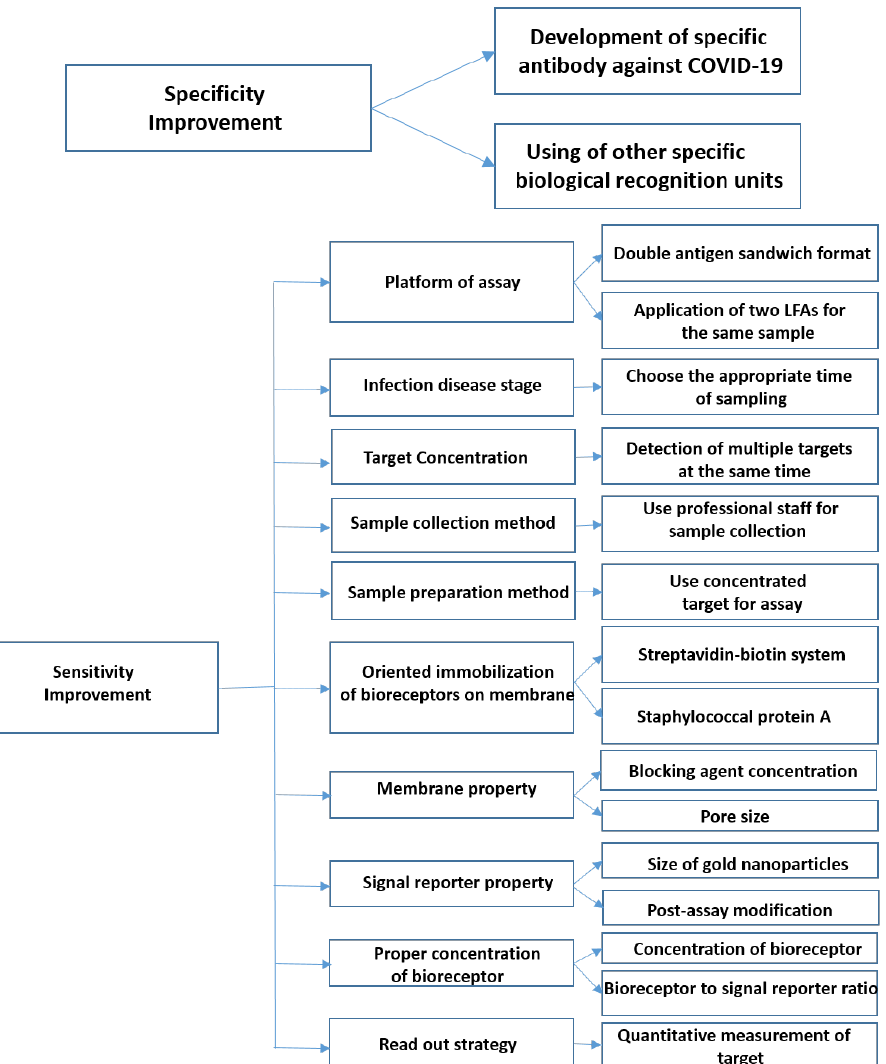
Figure 2. Approaches for improving the performance of LFAs. These methods can be divided into two groups: improvement of sensitivity and improvement of specificity.